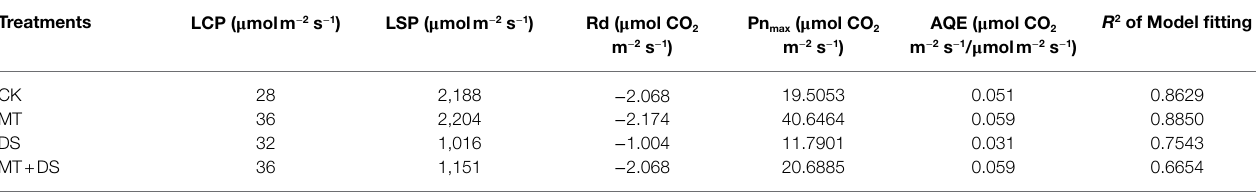
TABLE 1 | Simulation parameters of light response curve of triticale under different treatments for 20 days.